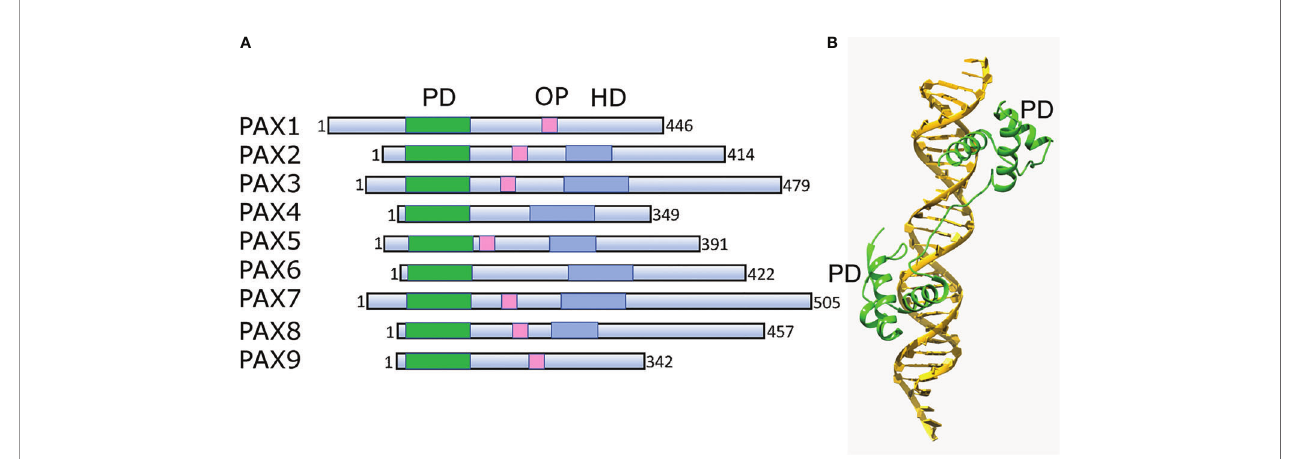
FIGURE 3 | Structural architecture of Pax family and its binding to DNA. (A) Schematic drawing of conserved structural domains of Pax family members. The domains include the conserved paired domain (PD, green), the de fi ning domain for this family. The Pax family members selectively contain other domains such as the homeodomain (HD, blue) and the octapeptide (OP, pink). (B) Ribbon diagram of Pax6 paired domain (PD) – DNA complex (PDBID: 6PAX). Crystal structure of the human Pax6 PD (primarily helix-turn-helix motif)-DNA complex reveals the region/subdomain involved in DNA